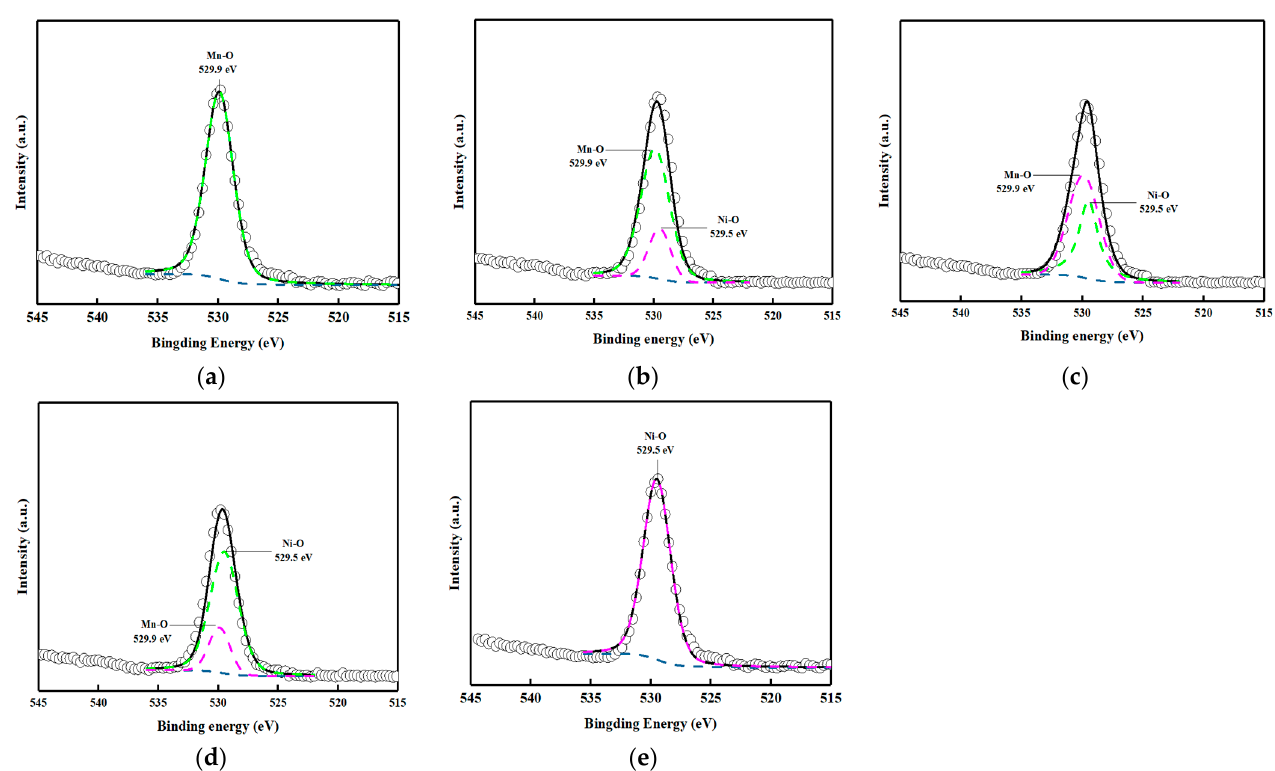
Figure 6. The O 1s of the XPS spectra for ( a ) Sample (a), ( b ) Sample (b), ( c ) Sample (c), ( d ) Sample (d), and ( e ) Sample (e).